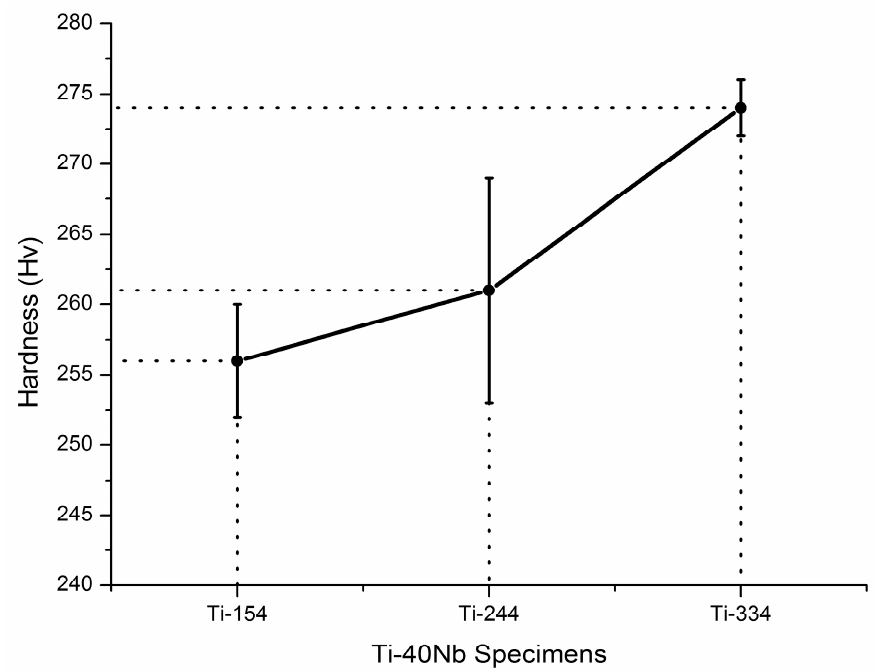
Figure 8. Vickers hardness of Ti-154, Ti-244 and Ti-334 specimens.